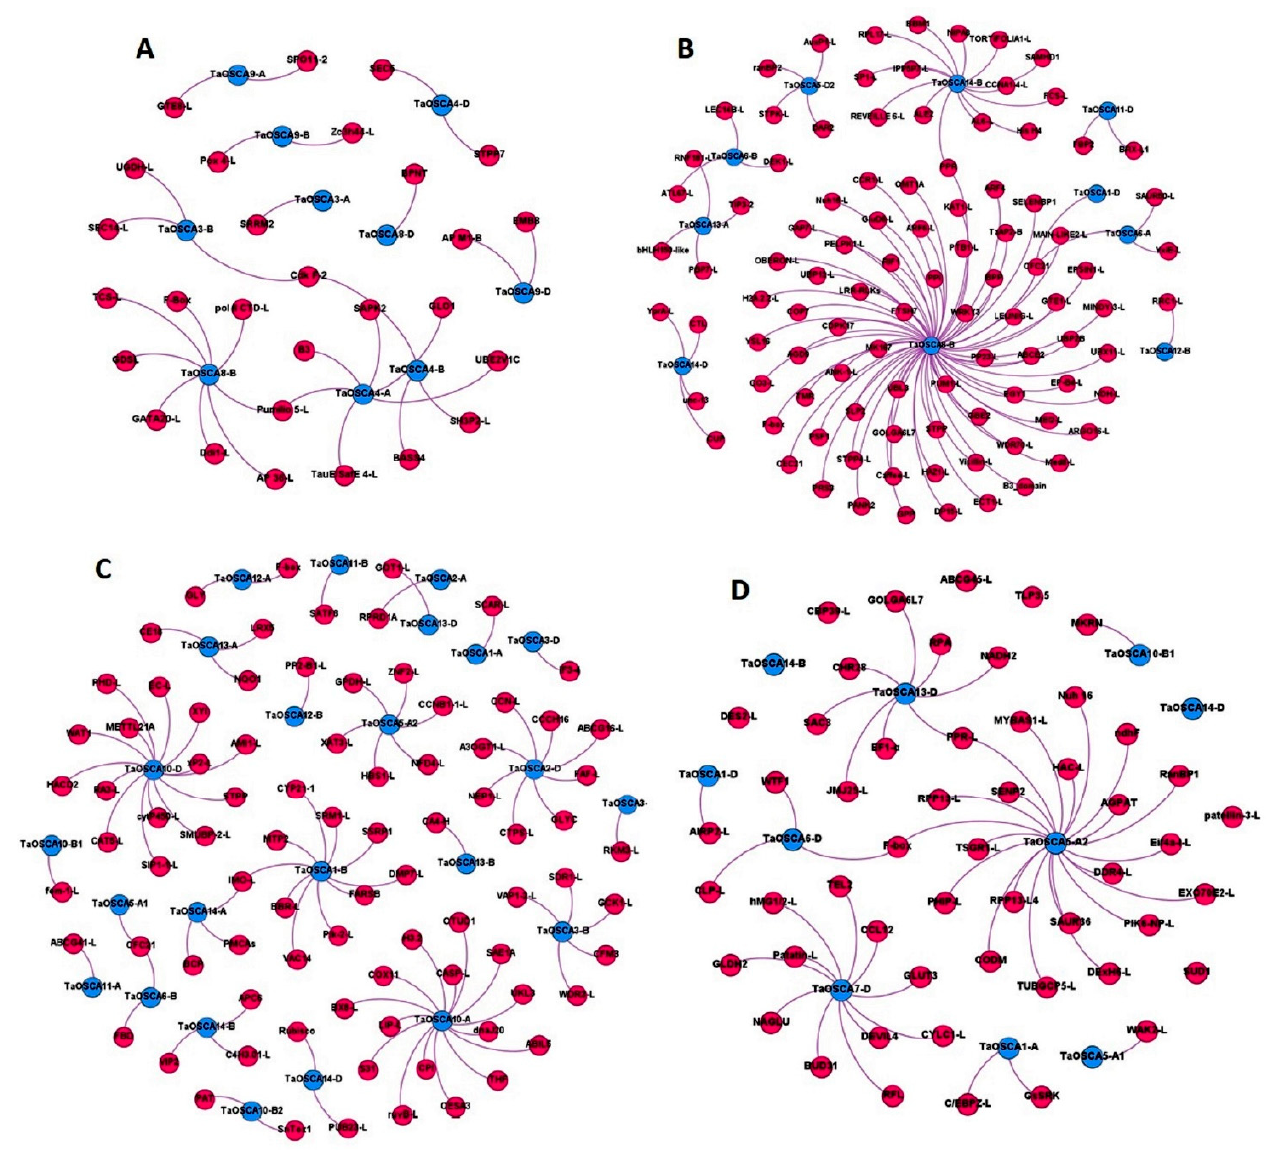
Figure 6. The interaction network analysis of OSCA genes with co-expressed genes was generated by using Gephi 0.9.1. The interaction network ( A ) shows co-expression in various tissues and developmental stages. The interaction network ( B ) shows the co-expression in the presence of HS, DS, and HS, ( C ) in salt, and ( D ) in biotic stress.